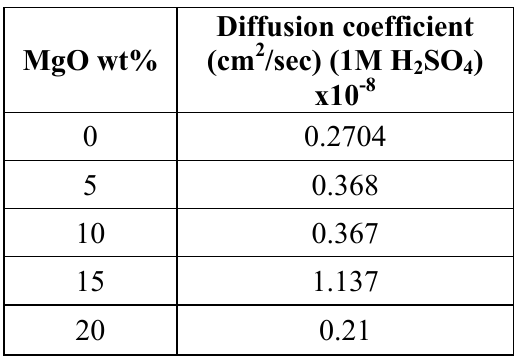
Table 1: Values of diffusion